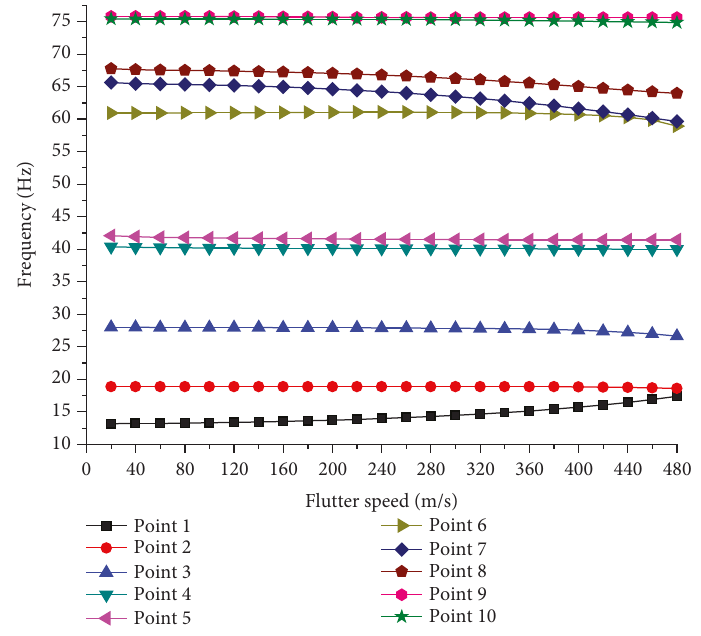
Figure 18: V ‐ f curve.